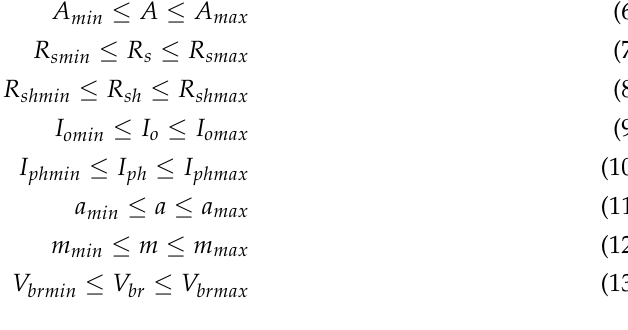
Table 2. Number of constraints for each